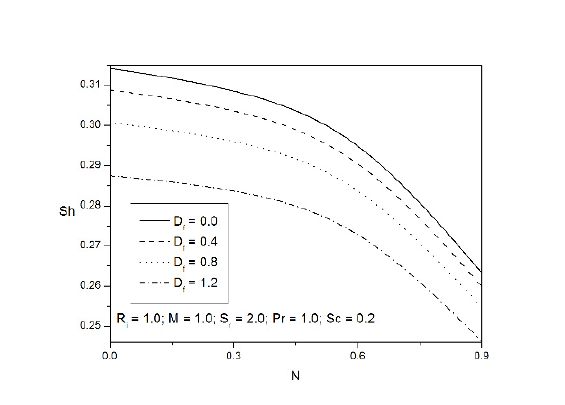
Figure 17. Effect of Dufour number D